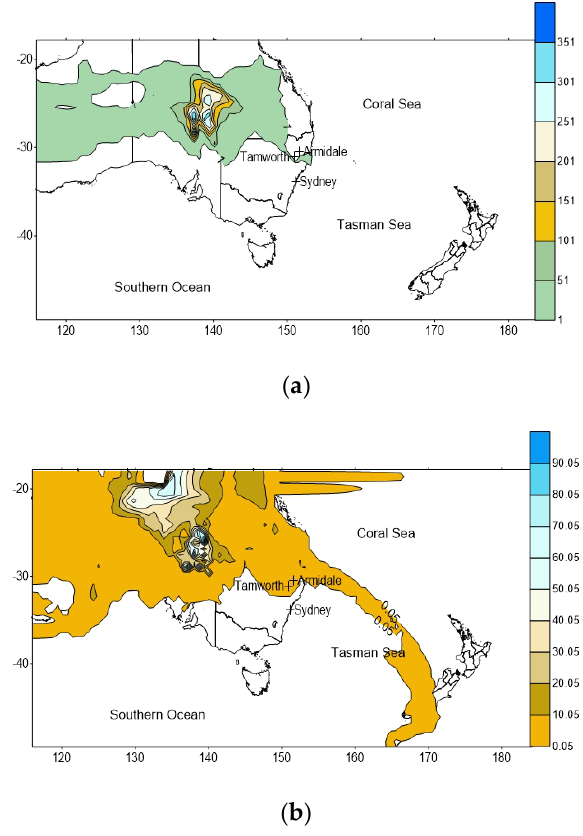
Figure 4. Concentration of dust particles (µg/kg dry-air) of bin 2 size (1 to 1.8 µm) on ( a ) 13 February 2019 5:00 UTC and ( b ) 14 February 2019 4:00